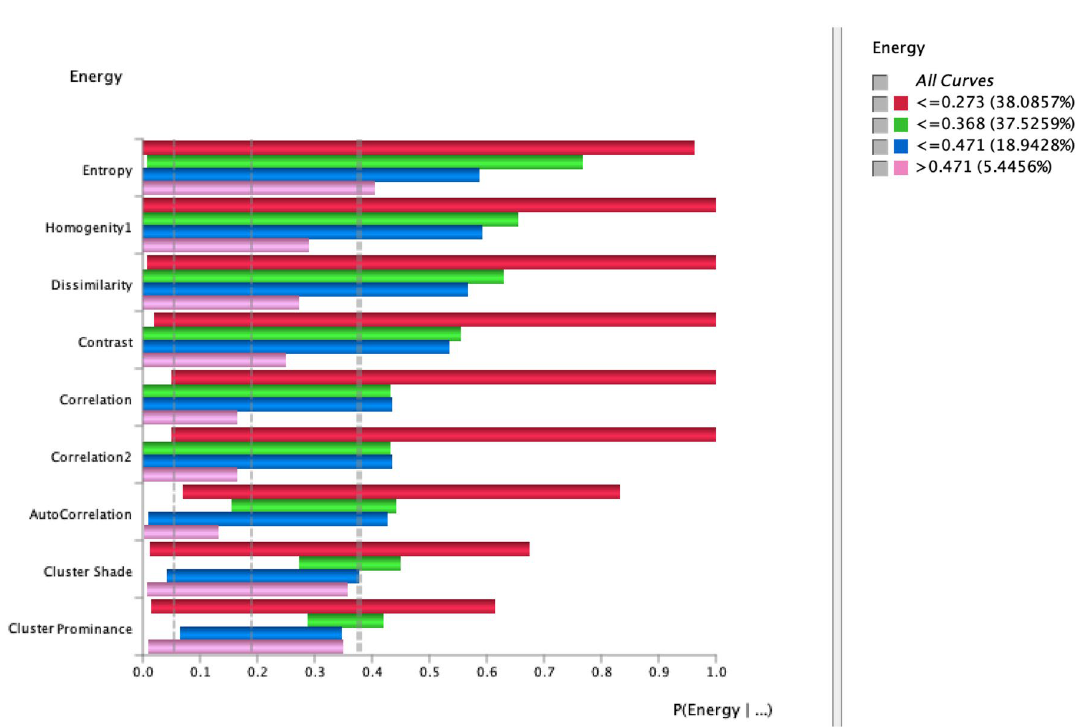
Figure 8. Tornado diagram of posterior probabilities to compute the significance of Energy node with all nodes at selected cluster states (≤ 0.273, ≤ 0.368, ≤ 0.471, and >